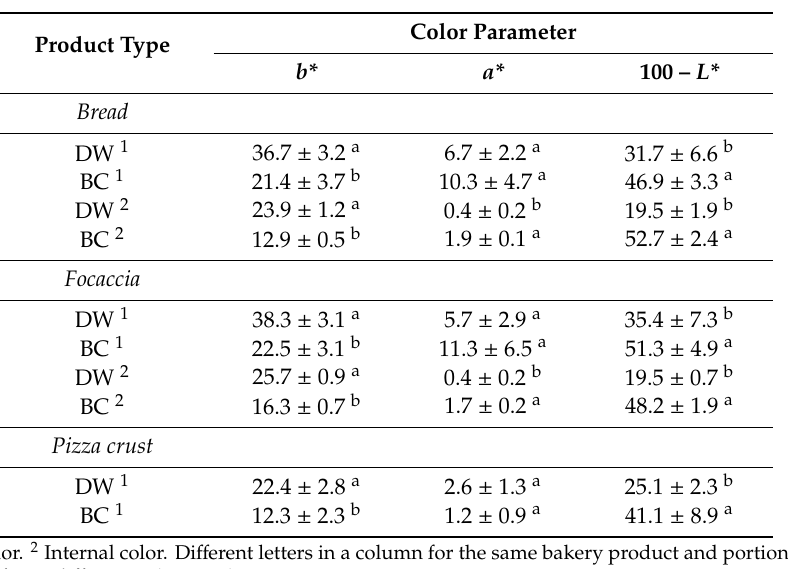
Figure 1. The internal structure of bread prepared by using a composite meal containing 60 / 100 g of durum wheat re-milled semolina and 40 / 100 g of Apulian black chickpea wholemeal flour ( left ) and bread prepared by using only durum wheat re-milled semolina ( right ). Table 8. Color parameters of conventional durum wheat bread, focaccia, and pizza crust and of their black, chickpea-enriched versions. DW = product prepared by using durum wheat re-milled semolina; BC = product prepared by using a composite meal containing 60 / 100 g of durum wheat re-milled semolina and 40 / 100 g of Apulian black chickpea wholemeal